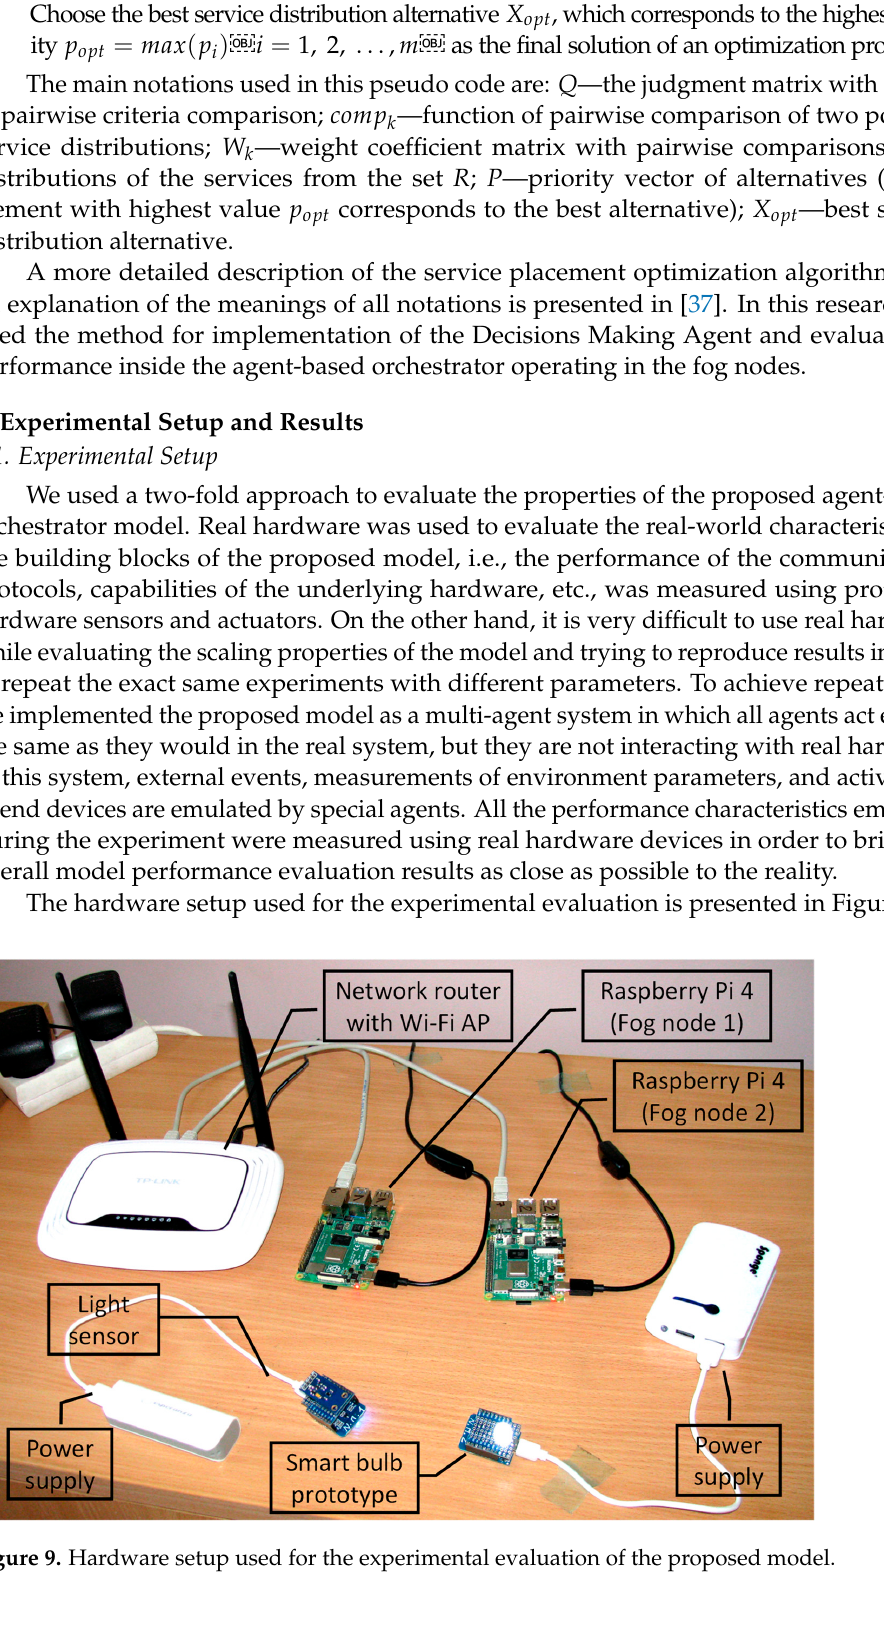
Figure 9. Hardware setup used for the experimental evaluation of the proposed model.